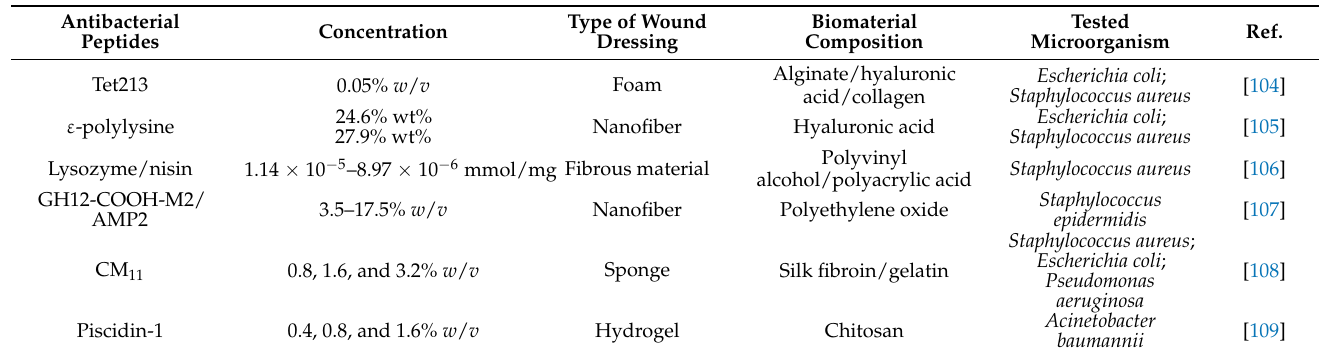
Table 5. Antibacterial AMP-loaded biomaterials for wound healing